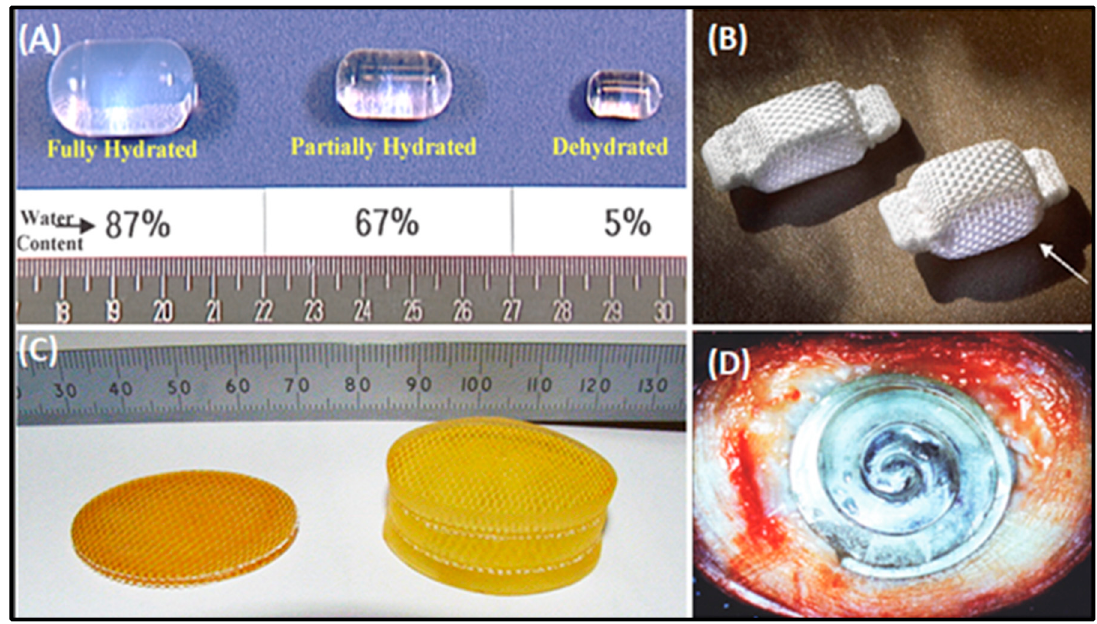
Figure 2. Nucleus replacement devices. ( A ) The Aquerelle poly (vinyl alcohol) hydrogel has a swelling pressure similar to the nucleus pulposus (NP) in vivo. Once implanted, its final volume depends on the water content at equilibrium (reprinted with permission from Stryker Spine, Allendale, NJ, USA). ( B ) The Prosthetic disc nucleus (PDN-SOLO) device in dehydrated (left) and hydrated (right; as indicated by arrow) states. This device was designed to swell both in height and width within the disc space. The porous polyethylene weave allows fluid to pass into the hydrophilic core, which causes the device to expand vertically and horizontally. This process maximizes the device’s footprint on the vertebral endplates (reprinted with permission from Raymedica Inc., Minneapolis, MN, USA). ( C ) The Neudisc hydrogel, pre-hydration (left) and post-hydration (right). Hydration occurs in an anisotropic fashion, mainly in the vertical plane (reprinted with permission from Replication Medical, Inc., New Brunswick, NJ, USA). ( D ) The Newcleus Spiral Implant; once implanted, the device reconstitutes its original spiral shape. It localizes in place of the nucleus pulposus, which reconstitutes the volume, sparing the annular fibers (reprinted with permission from Zimmer Spine, Warsaw, IN, USA) [10,45].